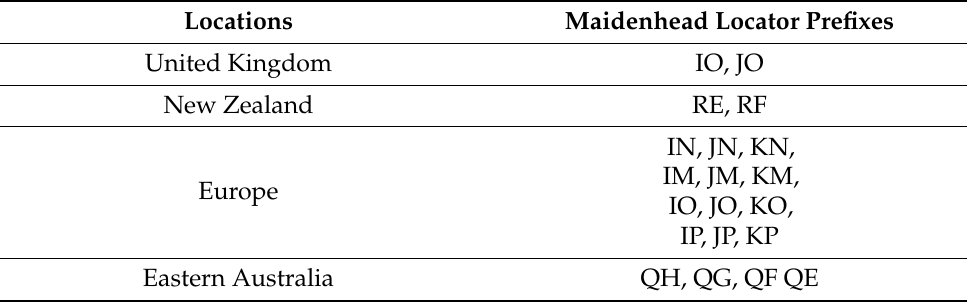
Table 3. Maidenhead locators starting prefixes of the locations.